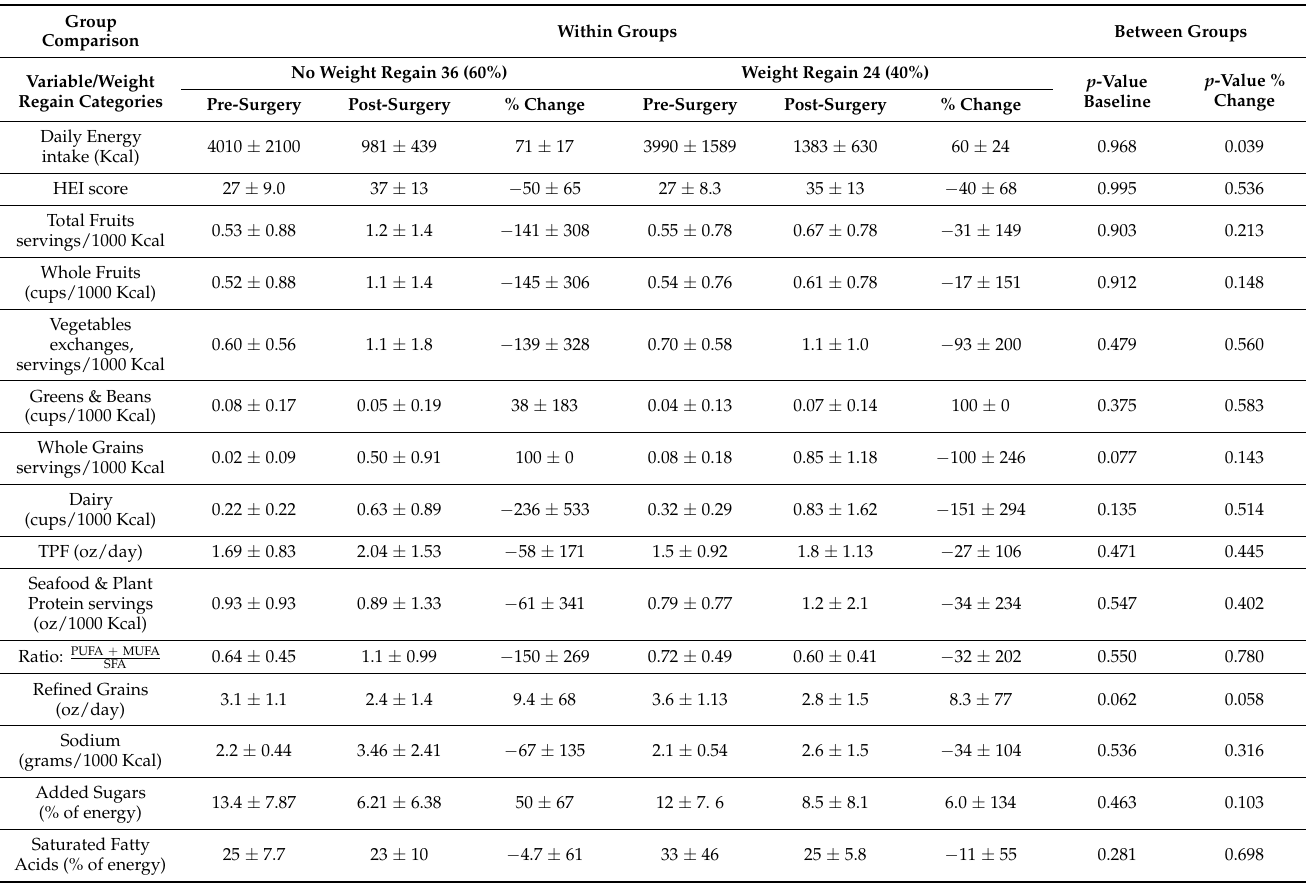
Table 3. Healthy Eating Index changes across weight regain categories (mean ±